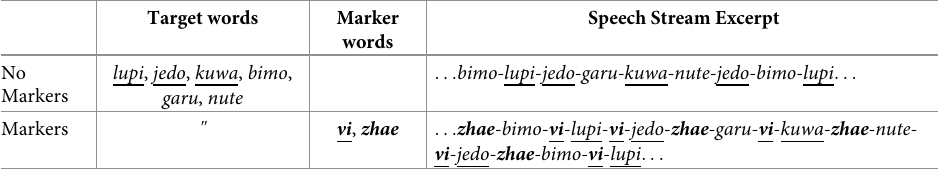
Table 1. Example speech streams for each condition in experiment